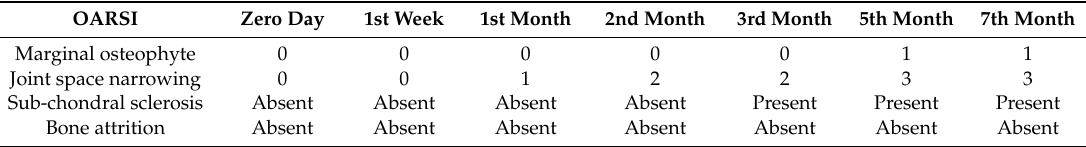
Table 2. Osteoarthritis Research Society International (OARSI) grading scores according to analysis of dorso-palmar radiographs.